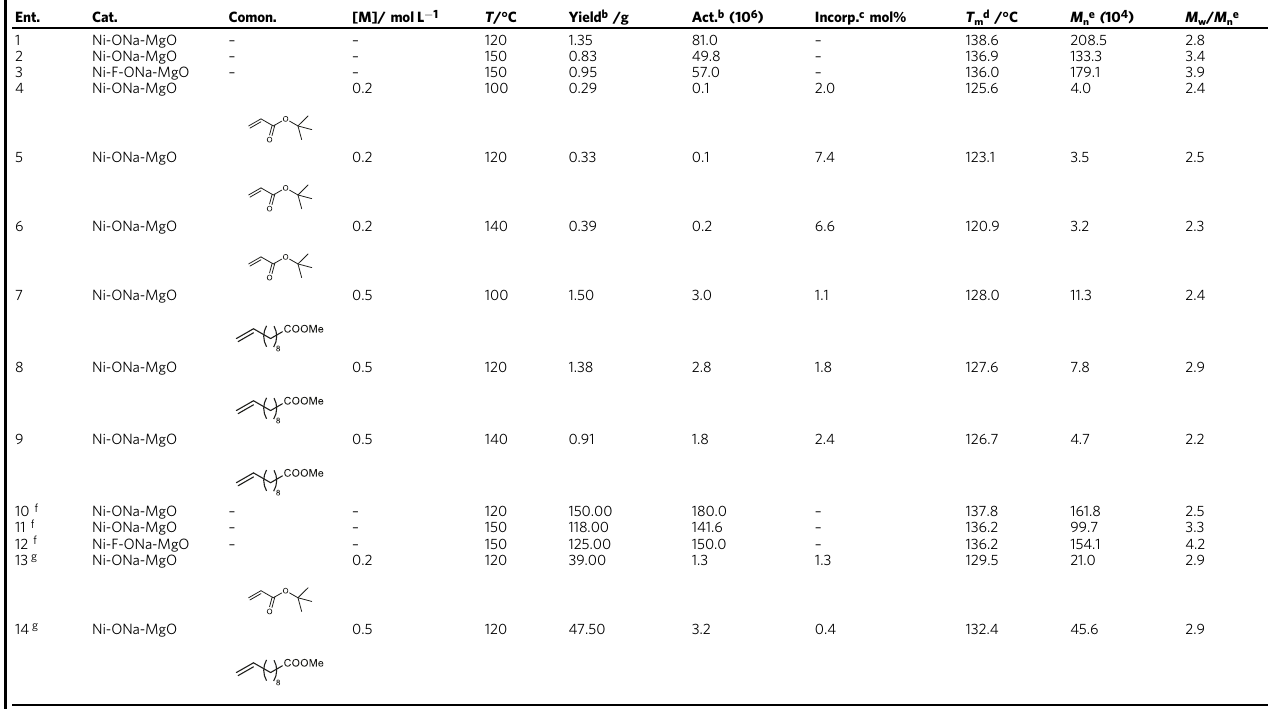
Table 4 Ethylene polymerization and copolymerization at high temperatures and large scale a . Ent.